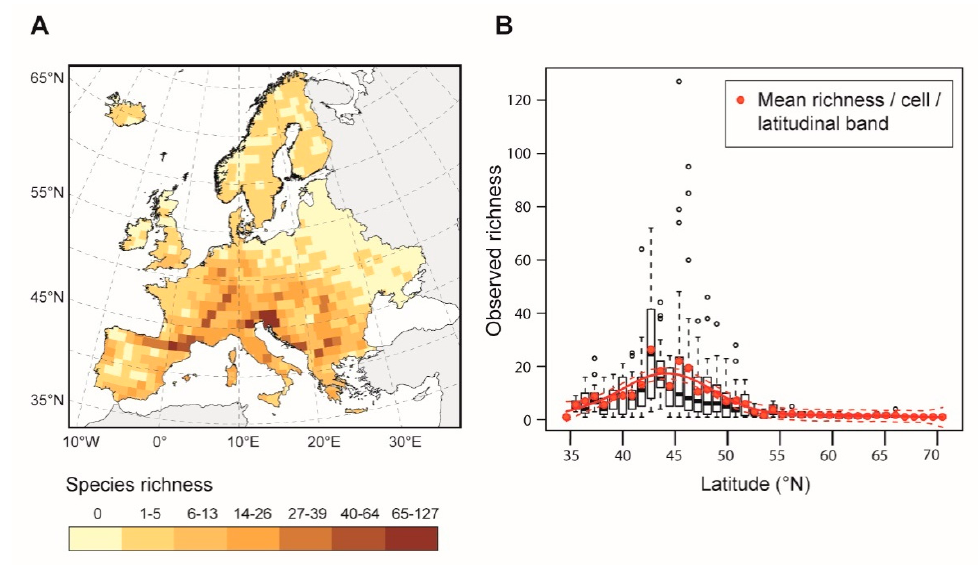
Figure 8. Map of species richness patterns of European stygobionts. ( A ) Species richness of 10,000 km 2